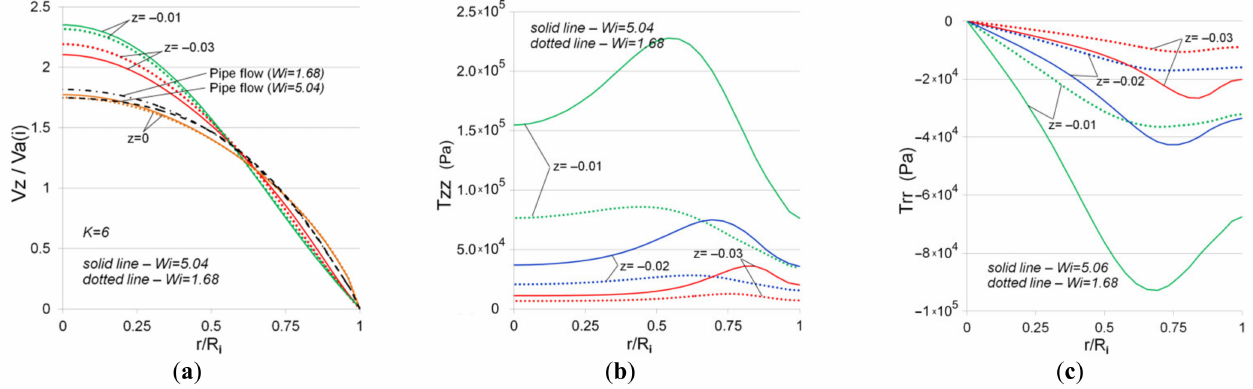
Figure 6. Normalized axial velocity ( a ) and normal stresses of extra stress tensor T ( b , c ) in the confusor for various initial swirl intensities, Wi = 5.04 (inlet) ( V a = 0.03 m/s at the inlet).